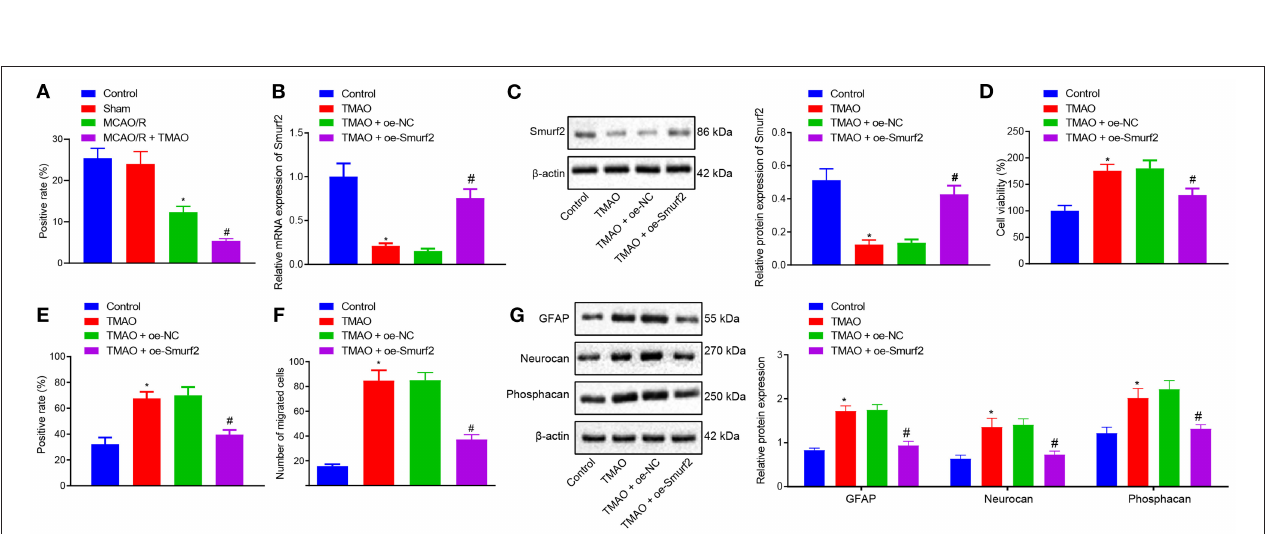
FIGURE 2 | Overexpression of Smurf2 suppresses the promoting effect of TMAO on proliferation, migration, and viability of astrocytes. (A) Smurf2 expression in rat brain tissues ( n = 15) detected by IHC assay. (B) Smurf2 expression in differently treated cells determined by RT-qPCR. (C) Smurf2 expression determined by western blotting in differently treated cells. (D) Results of CCK-8 assay on cell viability upon different treatments. (E) Proliferation of cells upon different treatments detected by EdU assay. (F) Migration ability of cells upon different treatments assessed by Transwell migration assay. (G) Protein expression of GFAP, Neurocan and Phosphacan determined using Western blotting in differently treated cells. * p < 0.05 compared with the control group. # p < 0.05 compared with the TMAO + oe-NC group. One-way ANOVA was employed for data comparison among multiple groups followed by Tukey’s post hoc test.